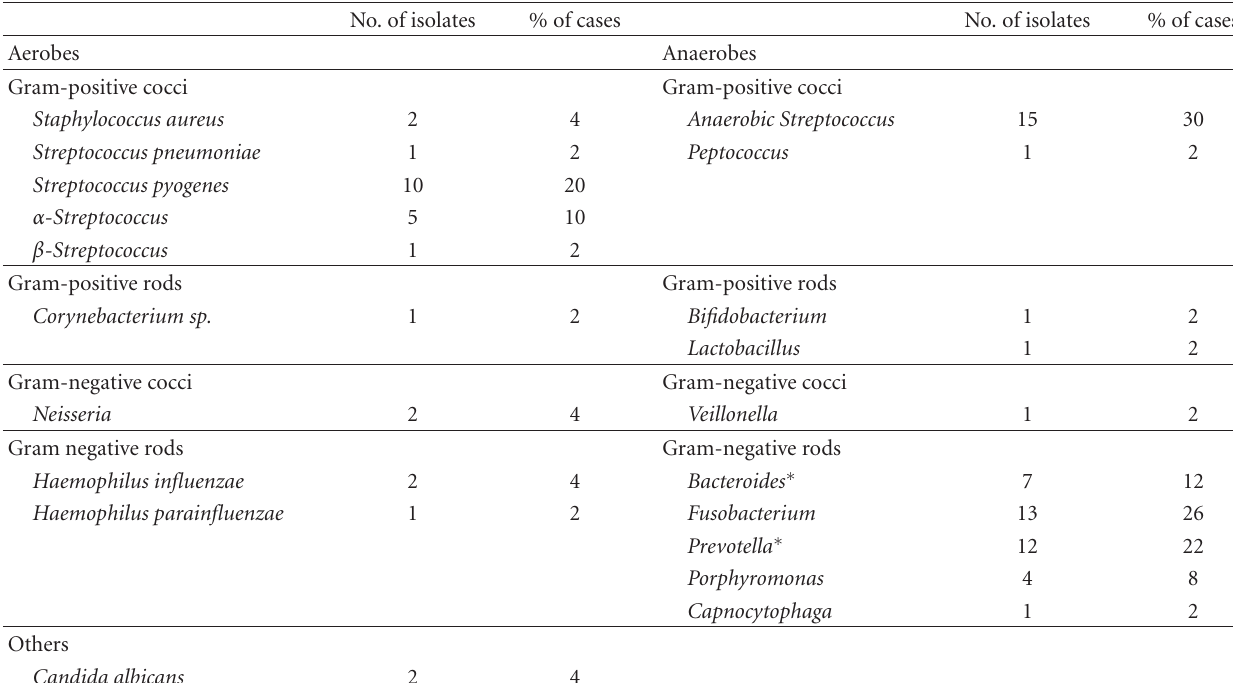
Table 1: Isolated organisms from the aspirates.